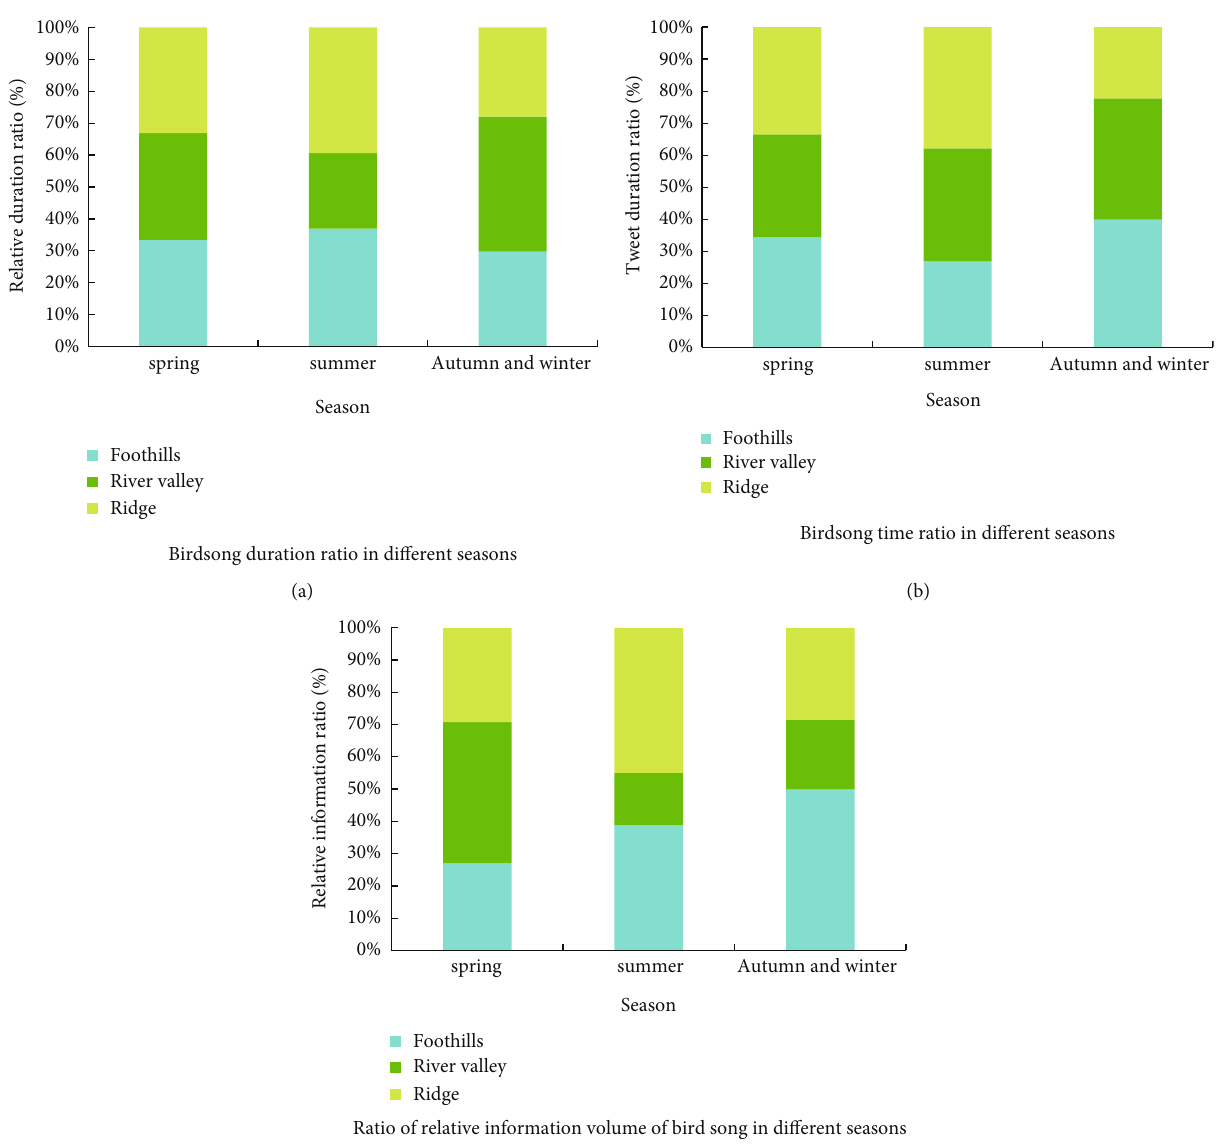
Figure 7: Birdsong activity changes in three di ff erent seasons. (a) Birdsong duration ratio in di ff erent seasons. (B) Birdsong time ratio in di ff erent seasons. (c) Ratio of relative information volume of bird song in di ff erent